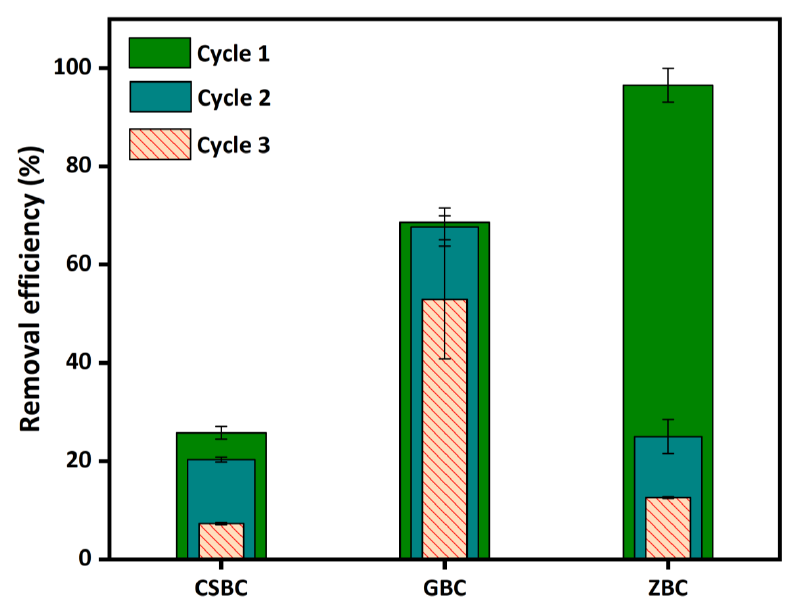
Figure 9. The removal efficiencies for P at each reuse cycle by the CSBC, GBC, and ZBC. (Adsorbent dose: 5 g L − 1 ; P initial concentration: 15 mg L − 1 ; adsorption time: 24 h; pH: 6; temperature: 25 °C; ionic strength: 0.01 M; desorption concentration: 0.5 M NaOH; desorption time: 24 h.)